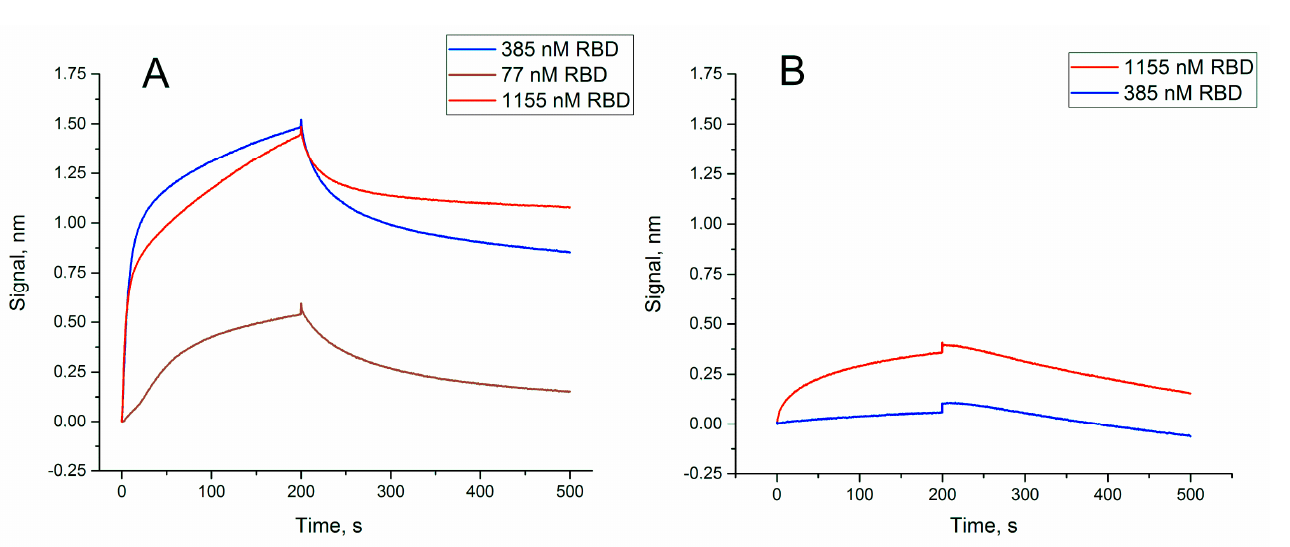
Figure 2. Sensorgrams of the interaction between soluble RBD of S-protein and immobilized oligonucleotides: ( A ) RBD-1C; ( B ) RBD-1C-sh. The concentrations of protein are provided in the graphs.